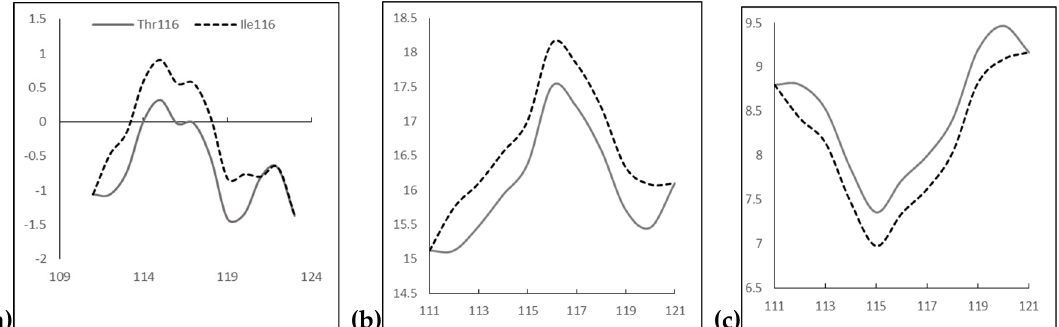
Figure 2. ExPASY prediction on PSEN T116I: ( a ) Kyte and Dootile hydrophobicity scores; ( b ) bulkiness scores; and ( c ) polarity scores.